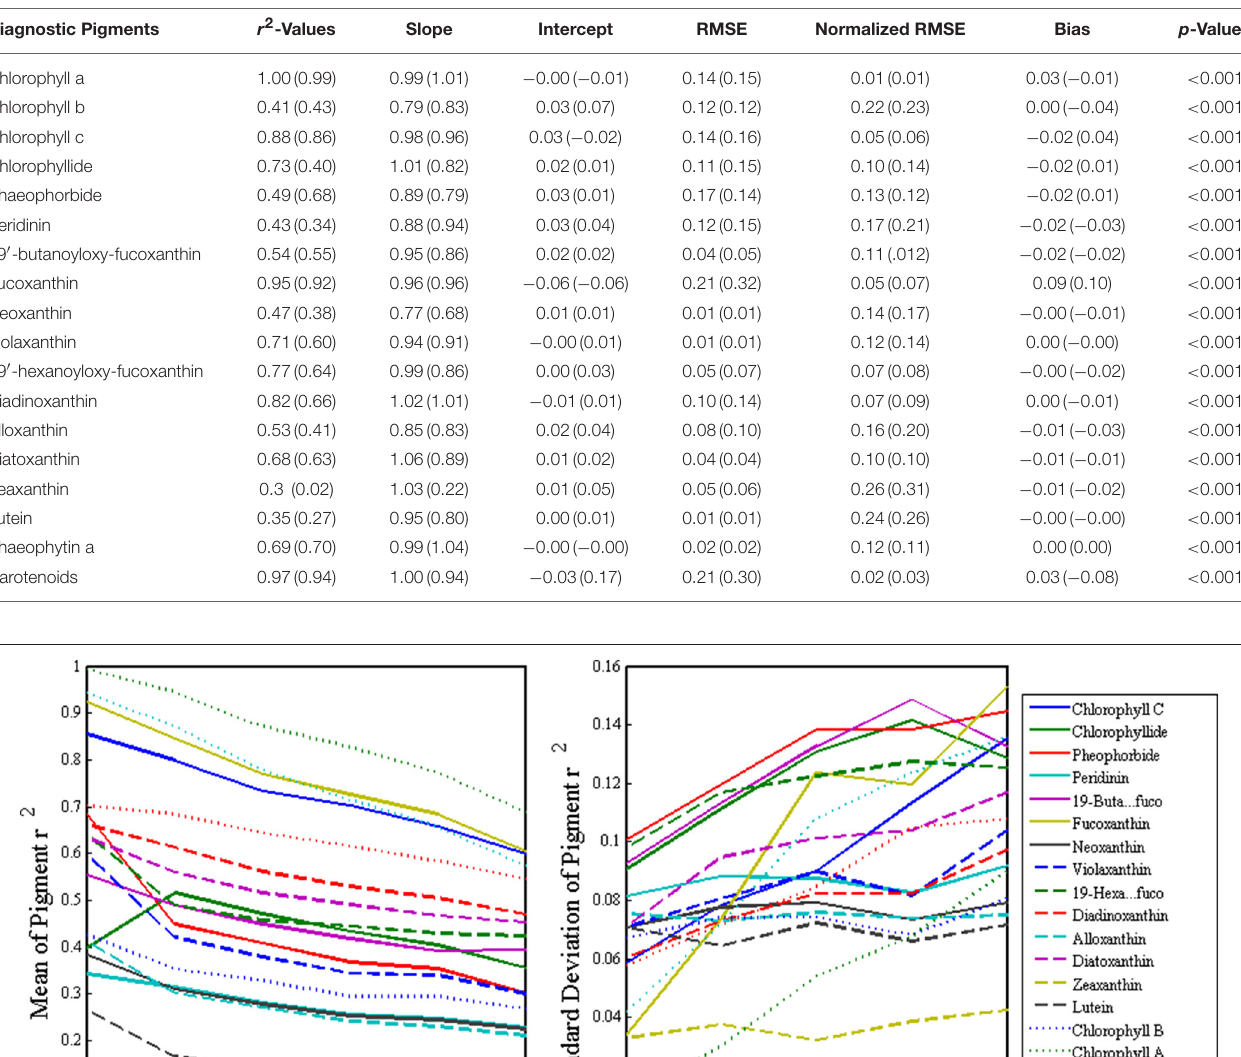
TABLE 3 | Statistical values derived from comparison of measured pigment concentrations with those estimated from the SVD-NNLS inversions using the measured (modeled) absorption spectra. Diagnostic Pigments